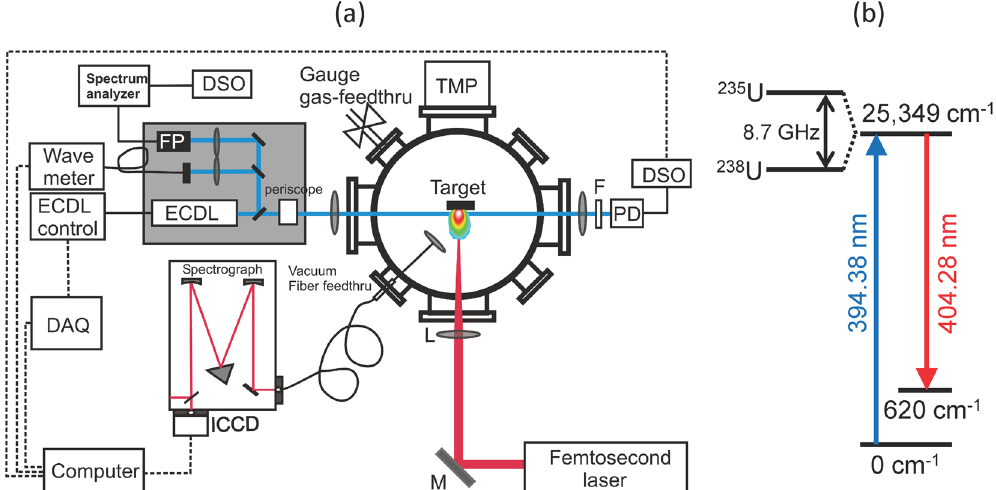
Figure 6. Schematic diagram of the experimental setup and uranium energy level information. Figure 6(a) Schematic of experimental setup. Femtosecond laser pulses were focused onto uranium metal targets held in a vacuum chamber at normal incidence. A tunable external cavity diode laser (ECDL) was propagated through the plasma for LIF and its transmitted intensity was measured on a photodiode (PD). Spatially-integrated LIBS and LIF emission were collected using a lens and multimode fiber placed outside the chamber and detected using a spectrograph with an ICCD. ( b ) Partial energy level diagram for uranium transitions used in